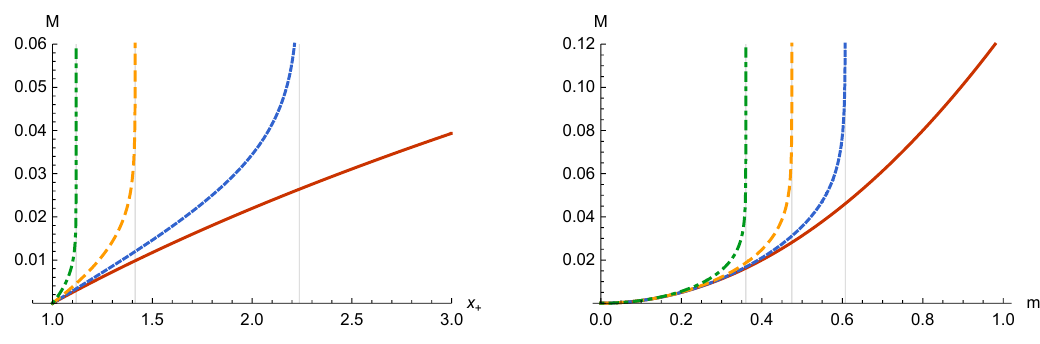
Figure 16 . The holographic mass M of the BTZ black-hole pushed by a strut at various values of the acceleration parameter: A = 0 (solid red), A = 0 . 5 ‘ − 1 (dotted blue), A = ‘ − 1 (dashed orange), A = 2 ‘ − 1 (dot-dashed